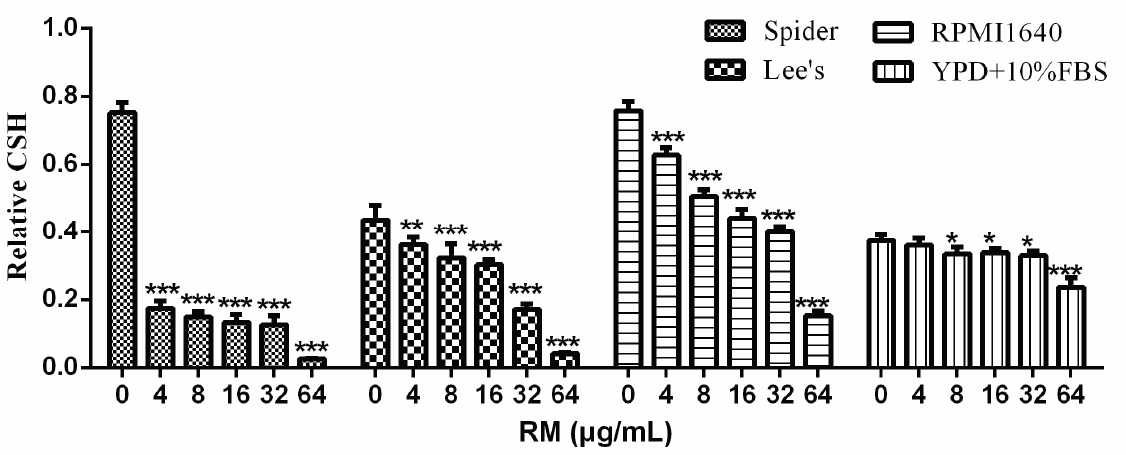
Figure 5. Effects of different concentrations of RM on CSH of C. albicans SC5314. The water-hydrocarbon two-phase assay was used to evaluate CSH. Standard deviations are based on three independent experiments. * p < 0.05; ** p < 0.01; *** p <